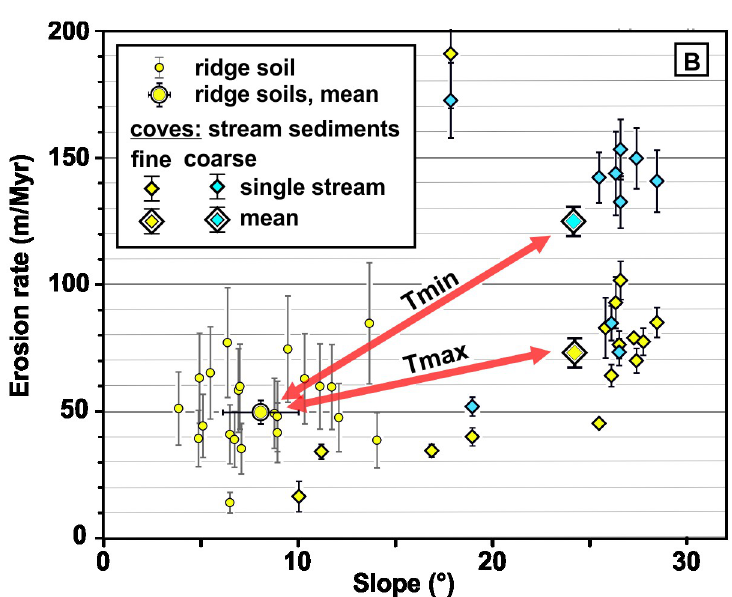
Fig 5. 10 Be-derived denudation rates as function of soil and catchment slope. Tmin , Tmax : arrows linking average values of erosion rates in the soils to the average values of erosion rates in streams, for the coarse and fine river sediment fractions. These two end-member fractions are used in the calculation of the time required to produce the observed landforms (see